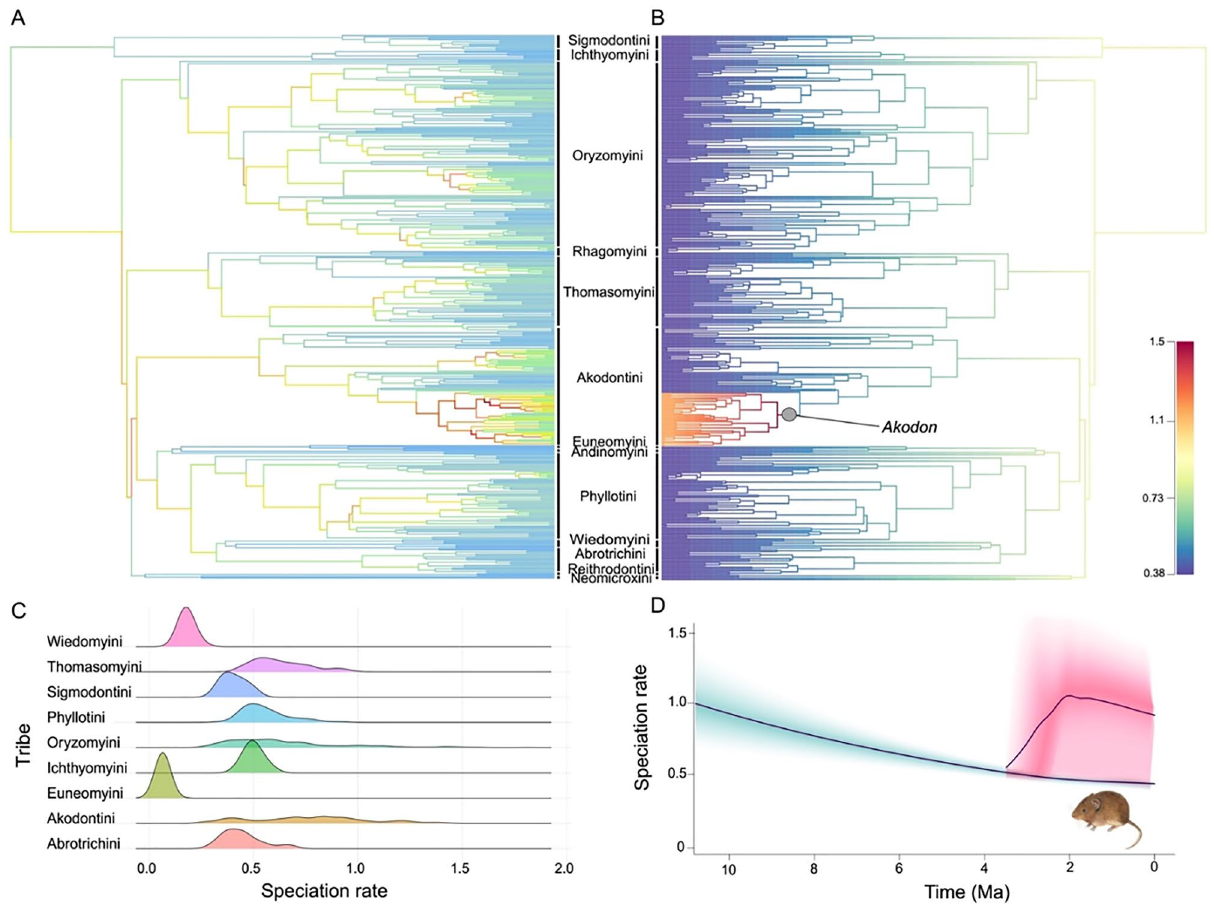
Figure 1. Macroevolutionary dynamics during the radiation of sigmodontine rodents. ( A ) Branch-specific speciation rates under the ClaDS2 model. ( B ) Speciation rate plot (mean phylorate) under BAMM model. The gray circle along the branch leading to the clade of the Akodon genus shows the best configuration shift identified by BAMM. Color intensity across branches is proportional to changes in speciation rate. ( C ) Branch- specific speciation rates under the ClaDS2 model by tribe. ( D ) Speciation-through-time trajectories for the Sigmodontinae subfamily (in green) and Akodon genus (in red). Illustration of Akodon rodent by Alayda Arce- Merma.